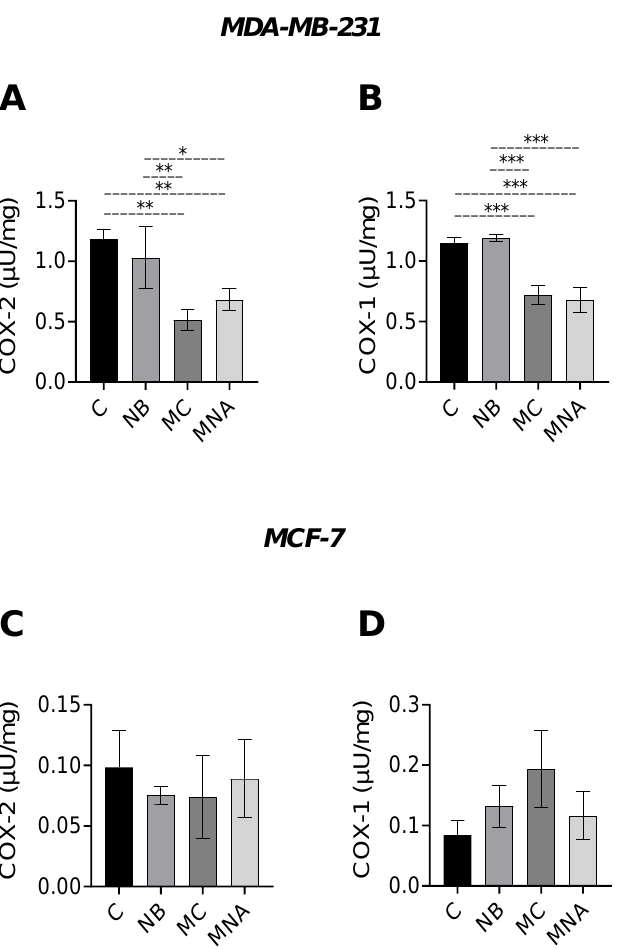
Figure 9. ( A ) COX-2 activity in MDA-MB-231 cells untreated (control, C) or treated with NB (35 µM), MC (25 µM) and MNA (35 µM). ( B ) COX-1 activity in MDA-MB-231 cells untreated (control, C) or treated with NB (35 µM), MC (25 µM), and MNA (35 µM). ( C ) COX-2 activity in MCF-7 cells untreated (control, C) or treated with NB (55 µM), MC (55 µM), and MNA (55 µM). ( D ) COX-1 activity in MDA-MB-231 cells untreated (control, C) or treated with NB (55 µM), MC (55 µM), and MNA (55 µM). In all cases, the cells were treated for 24 h, and all values are expressed as µU/mg protein. Data represent mean ± SEM, n = 3. * p ≤ 0.05, ** p ≤ 0.01 , *** p≤ 0.00 1 (one-way ANOVA and the nonparametric Newman – Keuls multiple comparison test).